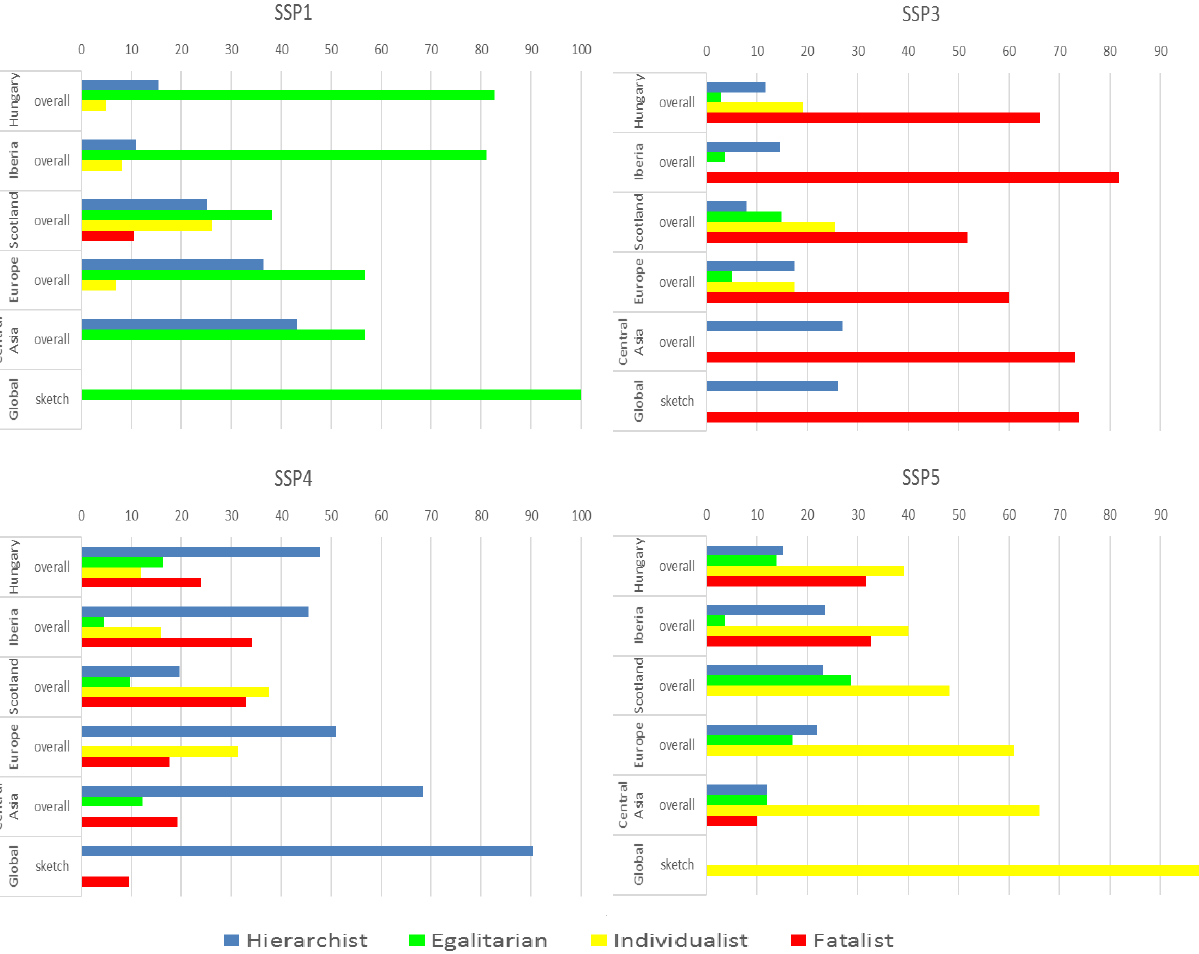
Figure A1: Analysis of worldviews (from expert